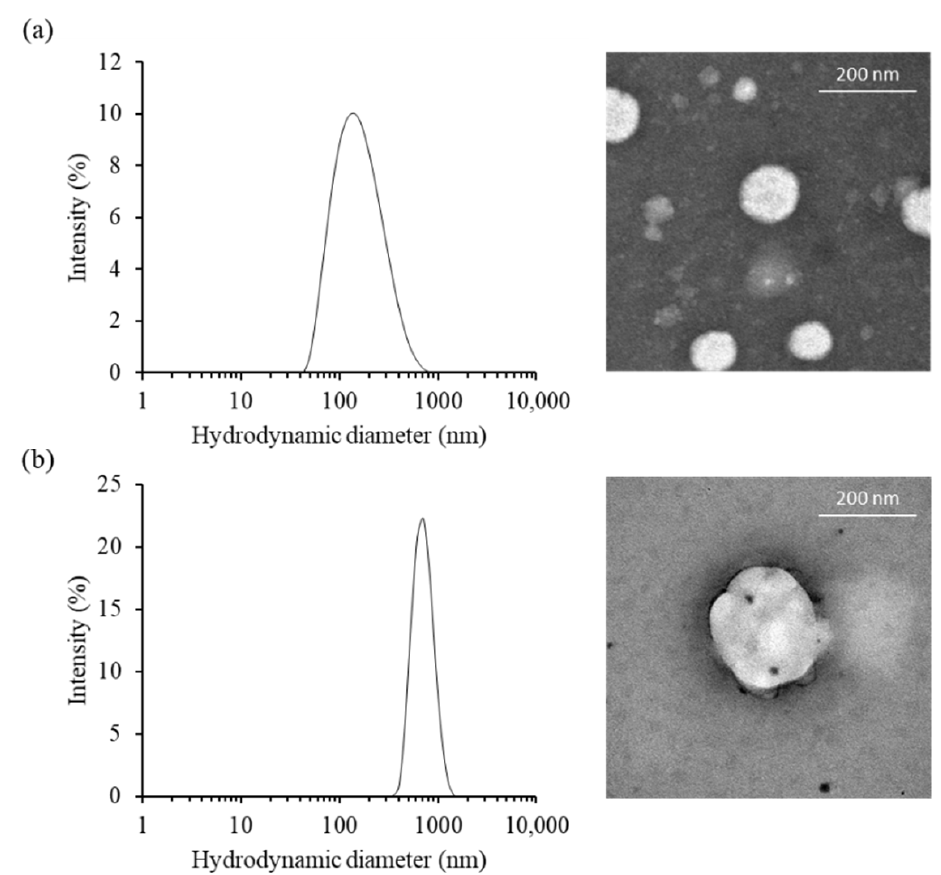
Figure 1. The physical characteristics of ( a ) PCN-B and ( b ) PCN-B/siRNA complexes, ( left ) the particle size distribution and ( right ) transmission electron microscopic (TEM) images.